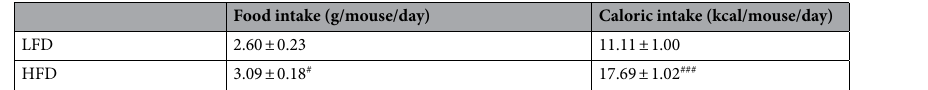
Table 1. Food and Caloric intake of mice fed 7 days with LFD or HFD. # p < 0.05, ### p < 0.001 vs.